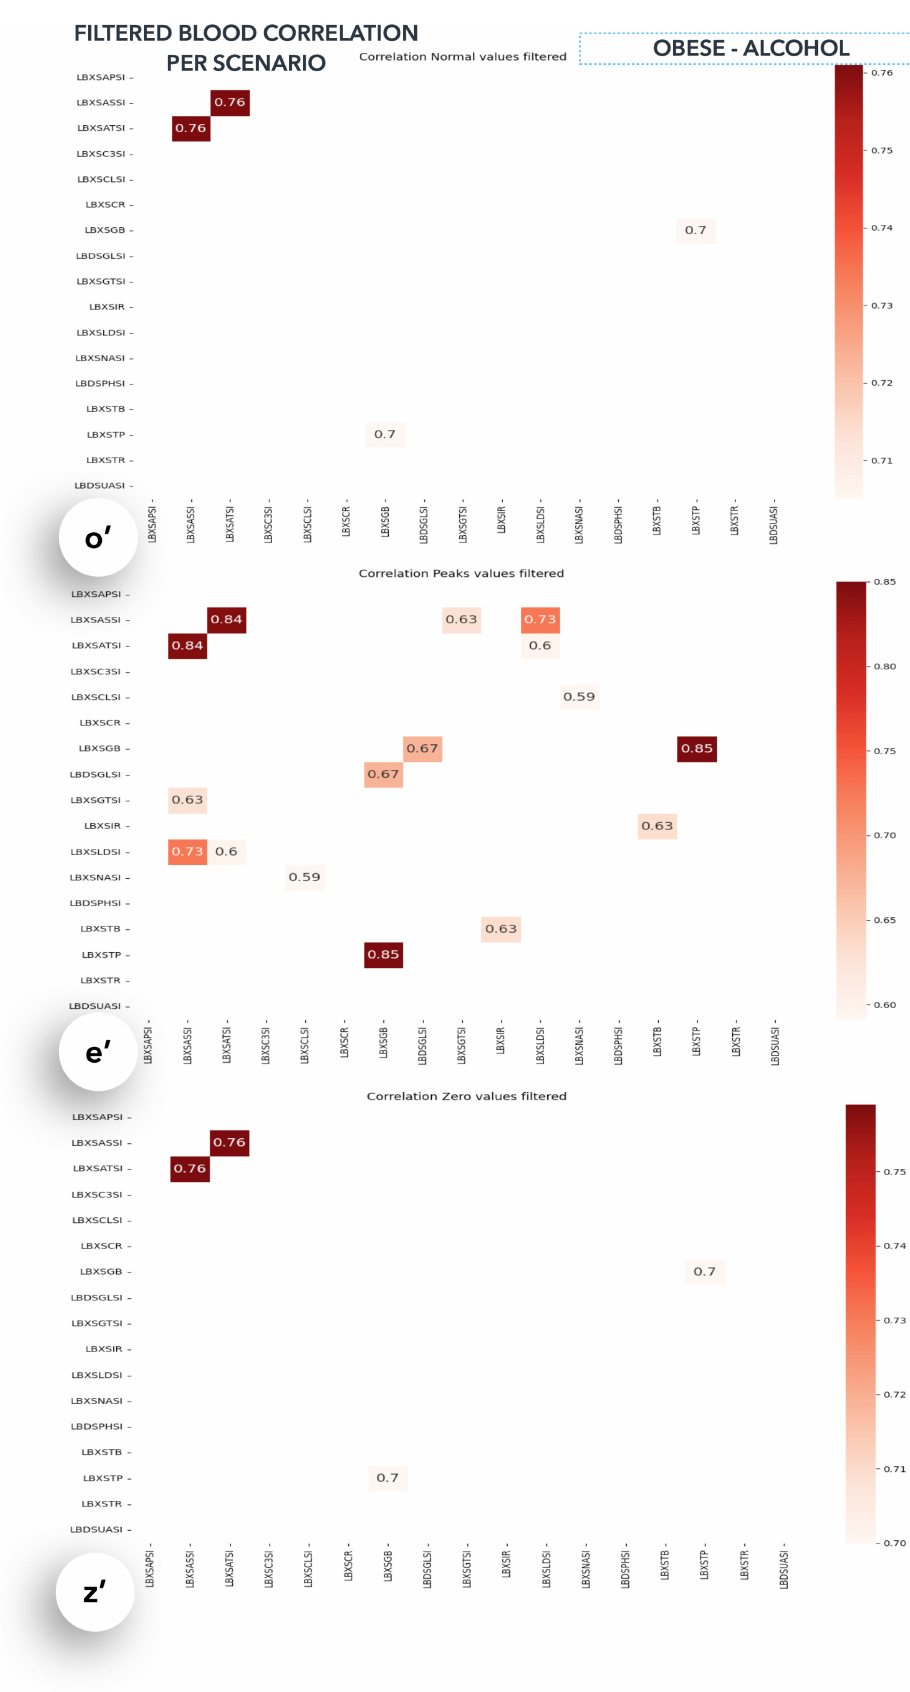
Figure 12. Obese category–alcohol. Filtered blood variable correlation as per EVA